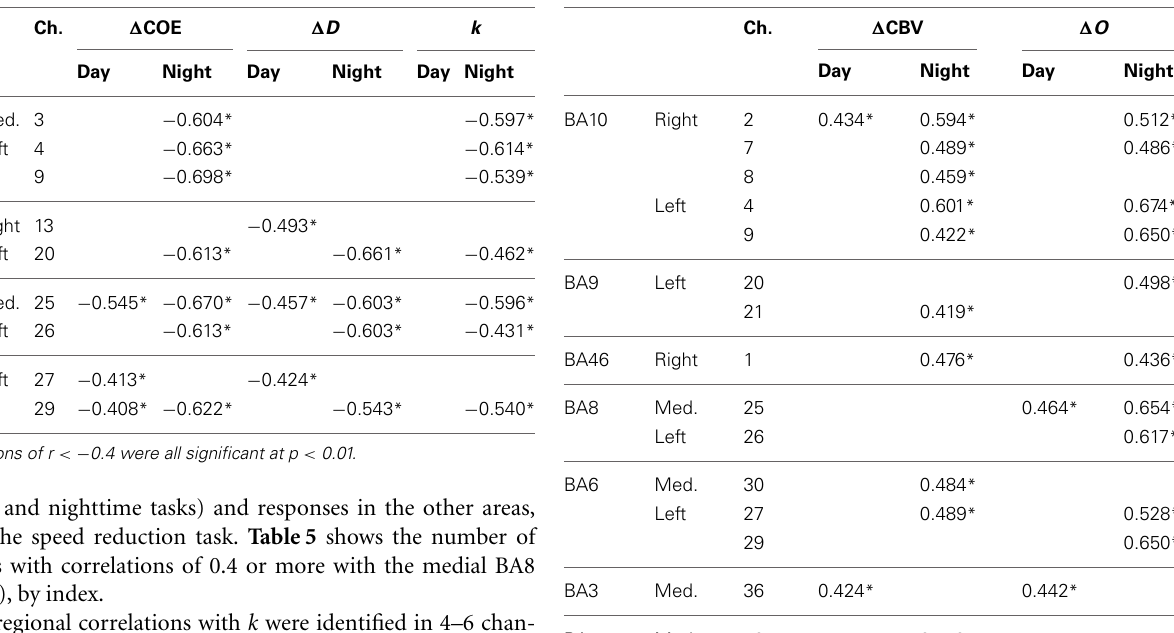
Table 2 | Negative correlations in the speed reduction task between vehicle acceleration and the brain activation indices.